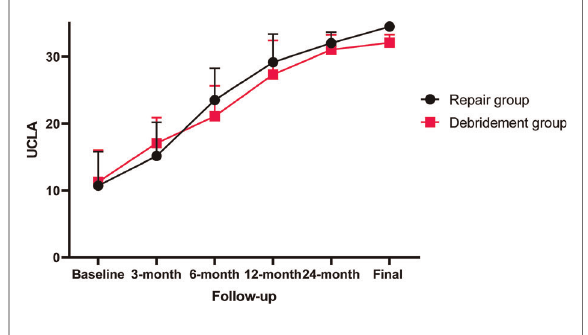
FIGURE 6 Postoperative UCLA scores of the two subgroups at different follow- up time.